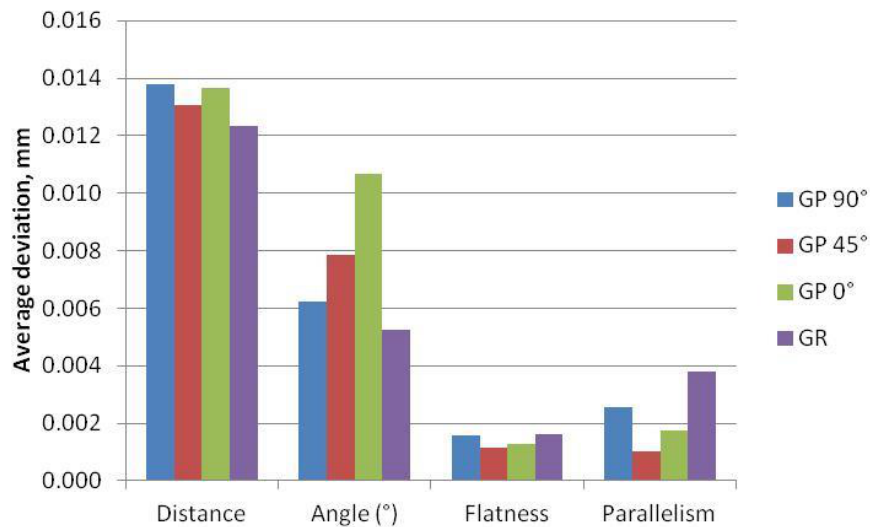
Figure 4. The average deviations for the four chosen tasks, measured on the gauge block using different path control algorithms.